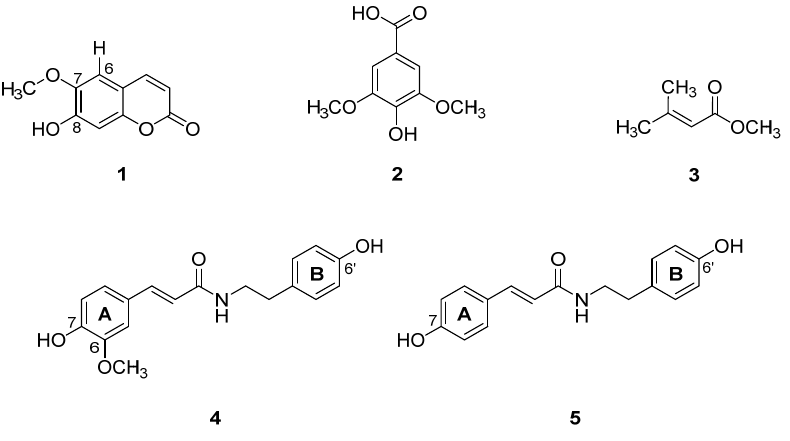
Figure 1. Isolated compounds ( 1 – 5 ) from N. racemosa